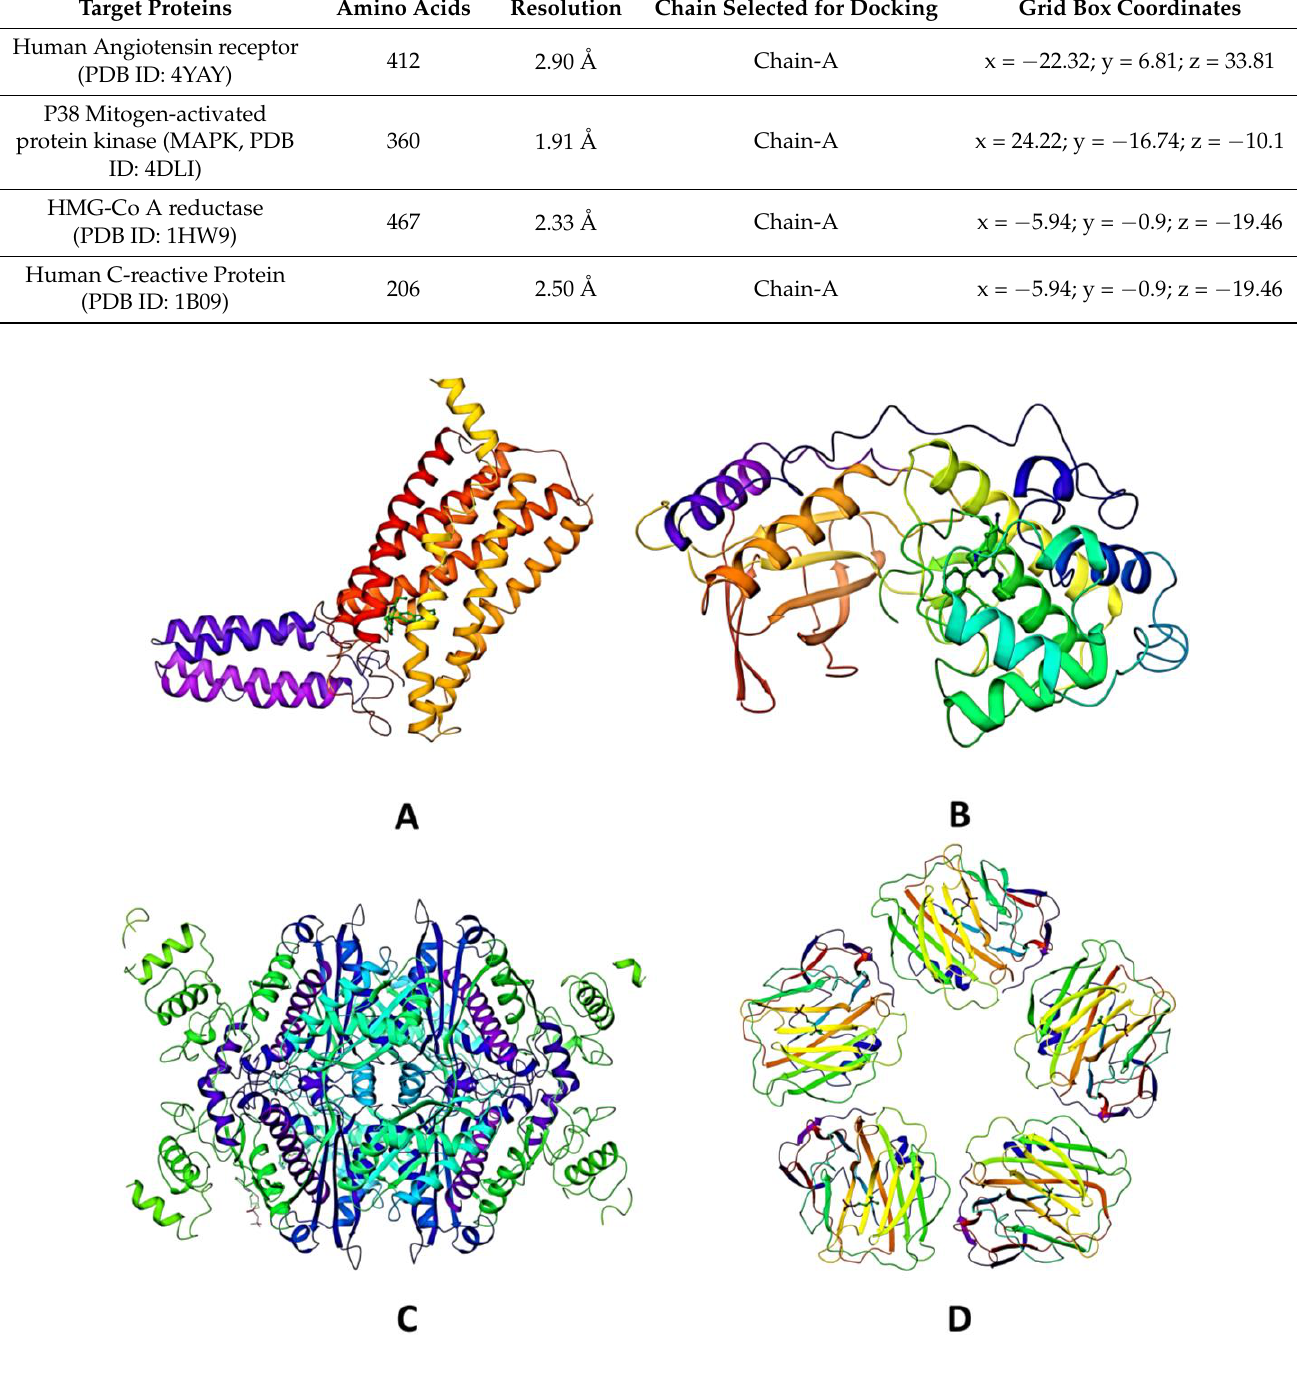
Figure 6. Three-dimensional structure of target proteins: ( A ) 4YAY, ( B ) 4DLI, ( C ) 1HW9, and ( D ) 1B09. Different colors of the chains indicate different types of chain- α -chains, β -pleated sheets etc. The N termini of proteins are blue in color.